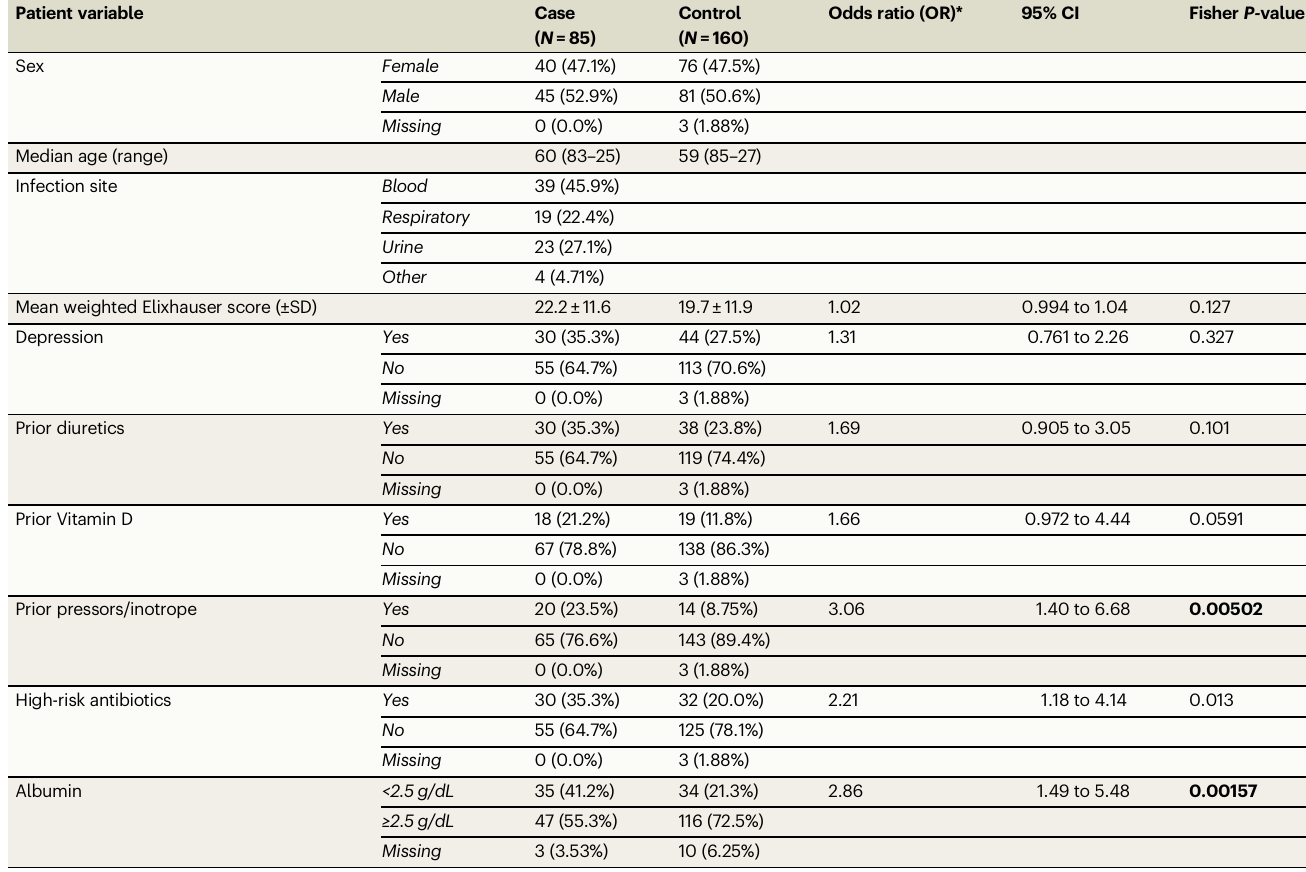
Table 1 | Patient demographics and select baseline characteristics Patient